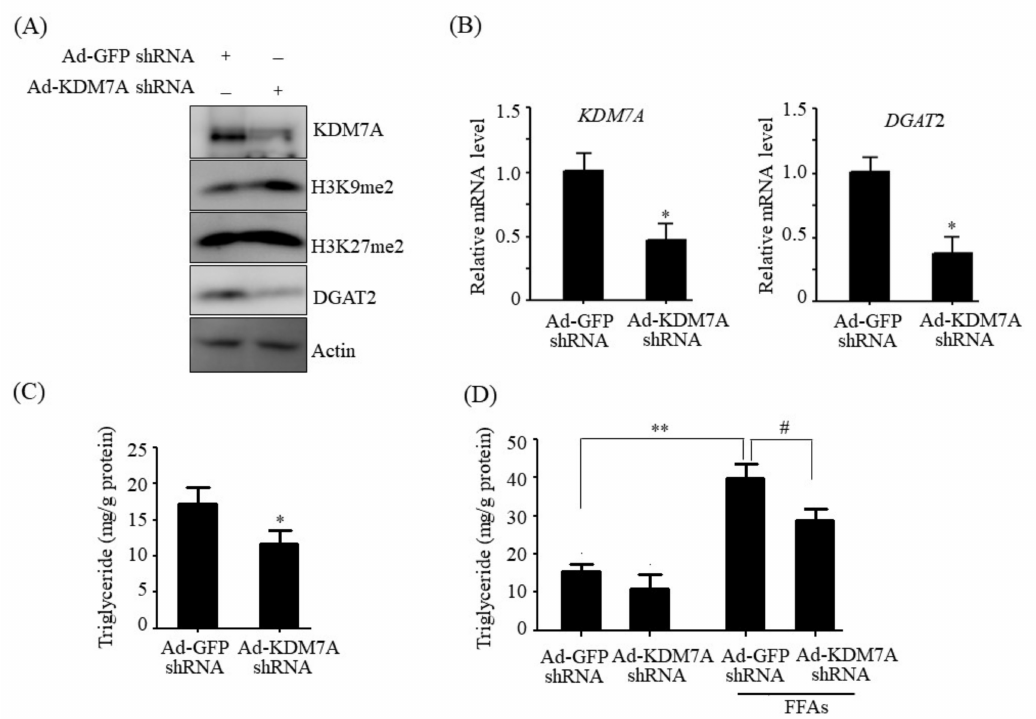
Figure 3. KDM7A knockdown decreases DGAT2 expression and TG level in AML12 cells. AML12 cells were infected with Ad-GFP shRNA or Ad-KDM7A shRNA. ( A ) Protein levels of KDM7A, H3K9me, H3K27me2 and DGAT2 were measured by Western blotting. ( B ) mRNA levels of KDM7A and DGAT2 were measured by qPCR. ( C ) Intracellular TG levels were measured using a TG assay kit. Data are presented as the mean ± SD from three independent experiments. * p < 0.05 vs. control (Ad-GFP shRNA). ( D ) AML12 cells were infected with Ad-GFP shRNA or Ad-KDM7A shRNA and then incubated with 1 mM FFAs for an additional 24 h. Intracellular TG levels were measured using a TG assay kit. Data are presented as the mean ± SD from three independent experiments. ** p < 0.01 vs. control (Ad-GFP shRNA). # p < 0.05 vs. FFAs-treated Ad-GFP